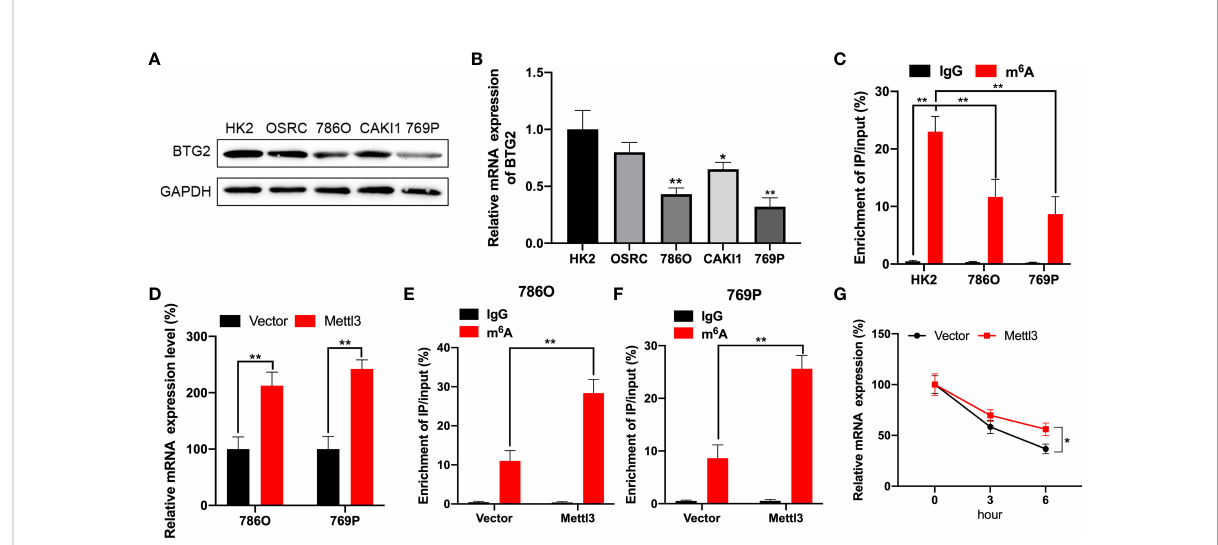
FIGURE 2 BTG2 expression and m 6 A methylation level in RCC cells. (A) The protein expression levels of BTG2 in RCC cells were detected using western blot. (B) The mRNA expression levels of BTG2 in RCC cells were detected using RT-qPCR. (C) The m 6 A methylation levels of BTG2 in RCC cells were detected using MeRIP-qPCR. (D) The mRNA expression levels of BTG2 in 786O and 769P cells after overexpressing Mettl3 were detected using RT-qPCR. E-F. The m 6 A methylation levels of BTG2 in 786O cell (E) and 769P cells (F) after overexpressing Mettl3 were detected using MeRIP-qPCR. (G) The mRNA expression levels of BTG2 in 786O cells after overexpressing Mettl3 and treatment with ActD for indicated times were detected using RT-qPCR. * P<0.05, **